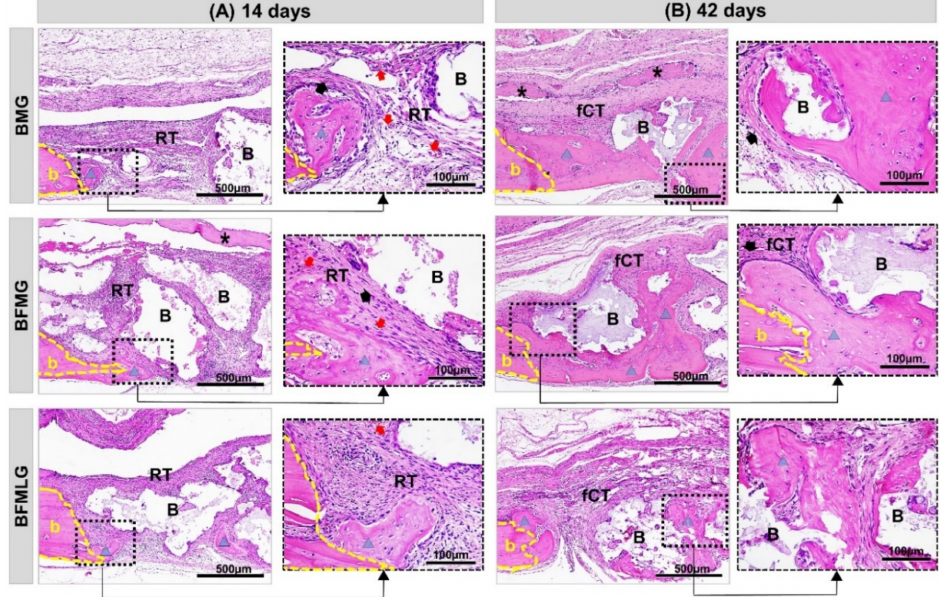
Figure 2. ( A , B ) Histological images of the evolution of defects in rat calvaria in the experimental periods of 14 and 42 days, respectively. BMG—defects filled with HA/ β -TCP covered by a bovine biological membrane; BFMG defects filled with HA/ β -TCP and heterologous fibrin biopolymer covered with bovine biological membrane; BFMLG defects filled with HA/ β -TCP and heterologous fibrin biopolymer covered with bovine biological membrane and PBMT. Bone border (b), reactive connective tissue (RT), biomaterial particles (B), bovine biological membrane (asterisk), new bone tissue (blue triangle), fibrous connective tissue (fCT), collagen fibers (black arrow), blood vessel cells (red arrow). H.E. Original 10 × magnification; bar = 500 µ m and inserts, enlarged 40 × images; bar = 100 µ m).